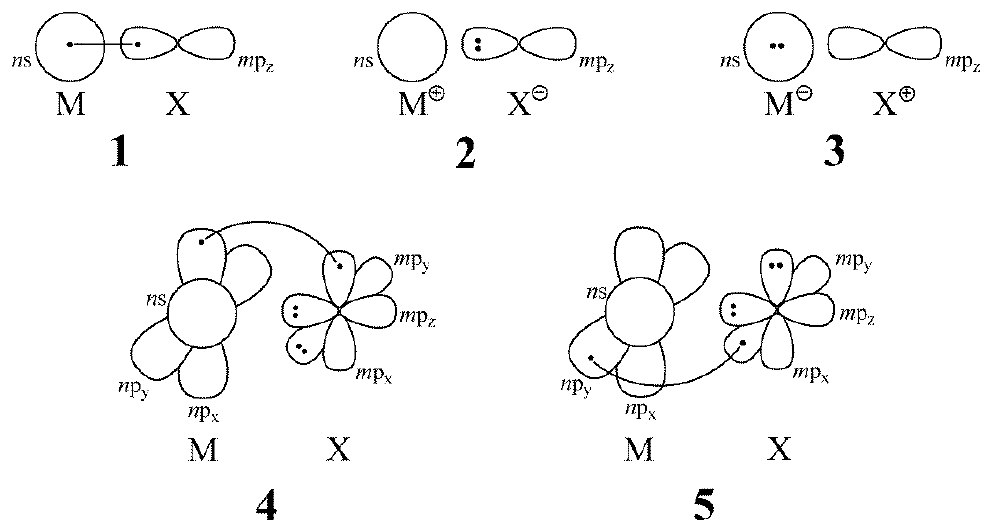
Figure 1. The selection of five VB structures describing the bonding in MX molecules (M = Cu, Ag, Au; X = F, Cl, Br).